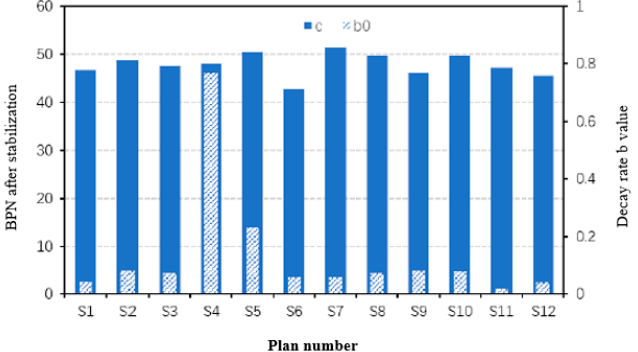
Figure 11. Comparison of BPN attenuation stability value and attenuation